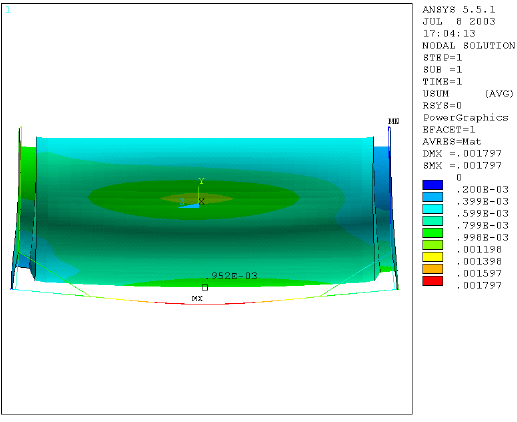
Figure 10. Nodal displacements.